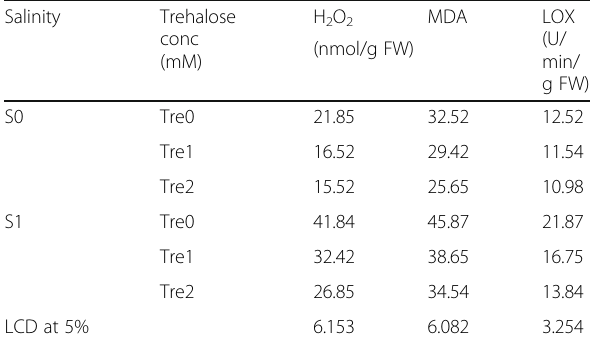
Table 4 Effect of trehalose at 0 mM (Tre 0), 10 mM (Tre 1),